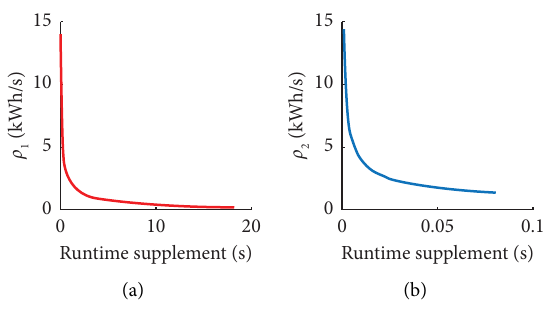
Figure 10: Te illustration of energy-saving efects ρ for the subinterval 1 (a) and 2 (b)